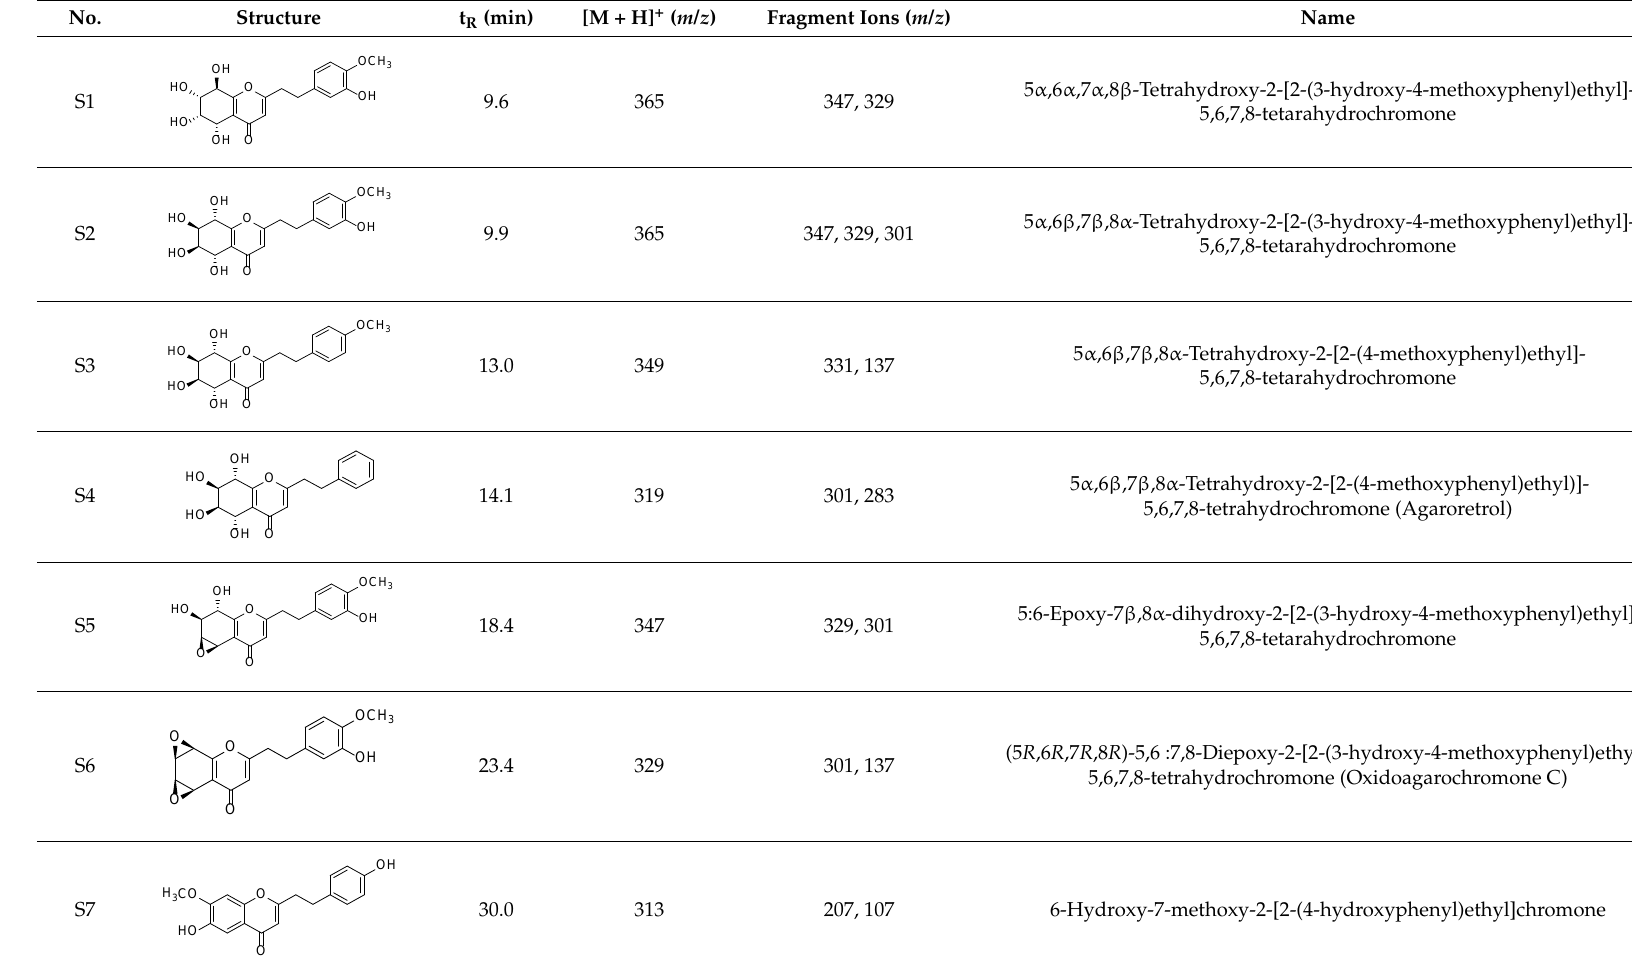
Table 3. Characterization of 30 reference compounds by using UPLC/ESI-MS/MS.